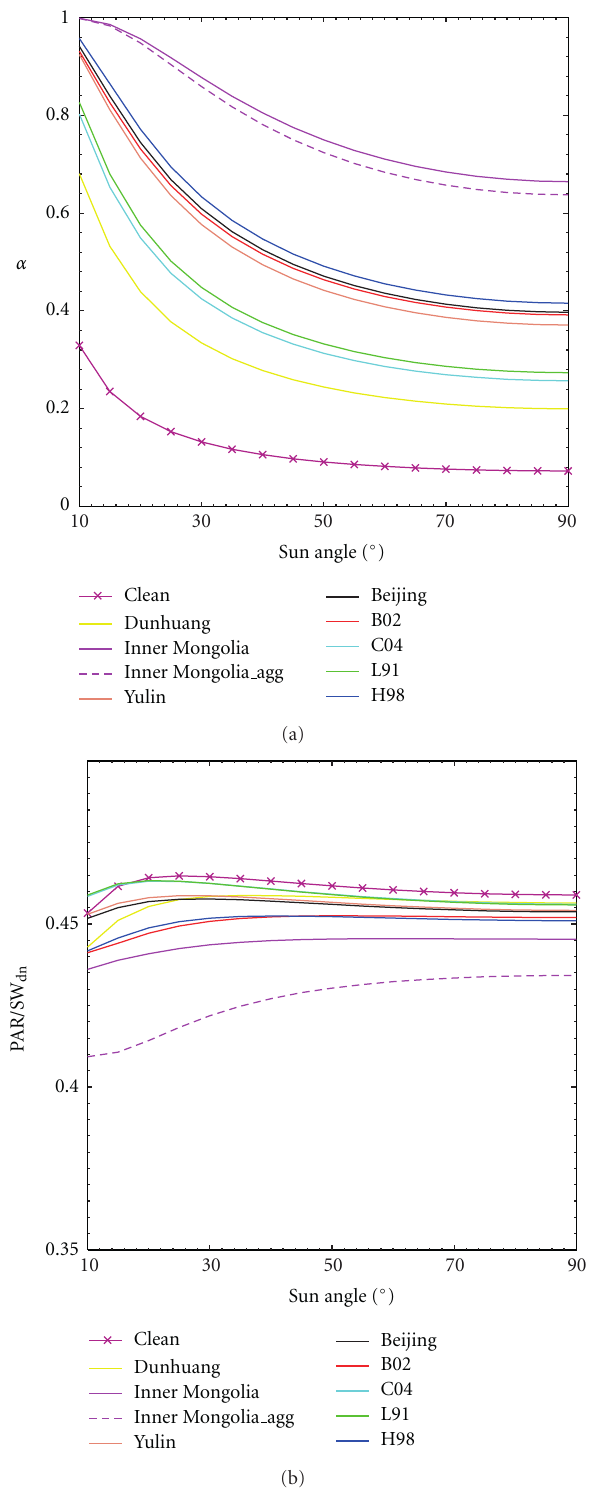
Figure 7: (a) Di ff use fraction ( α ) of PAR, and (b) the ratio of PAR to downwelling shortwave radiation, PAR / SW dn , as a function of sun elevation angle. Dust loading is M = 250 μ g m − 3 . Dust vertical profile is for the mixed layer case. The surface albedo is for the cropland-2